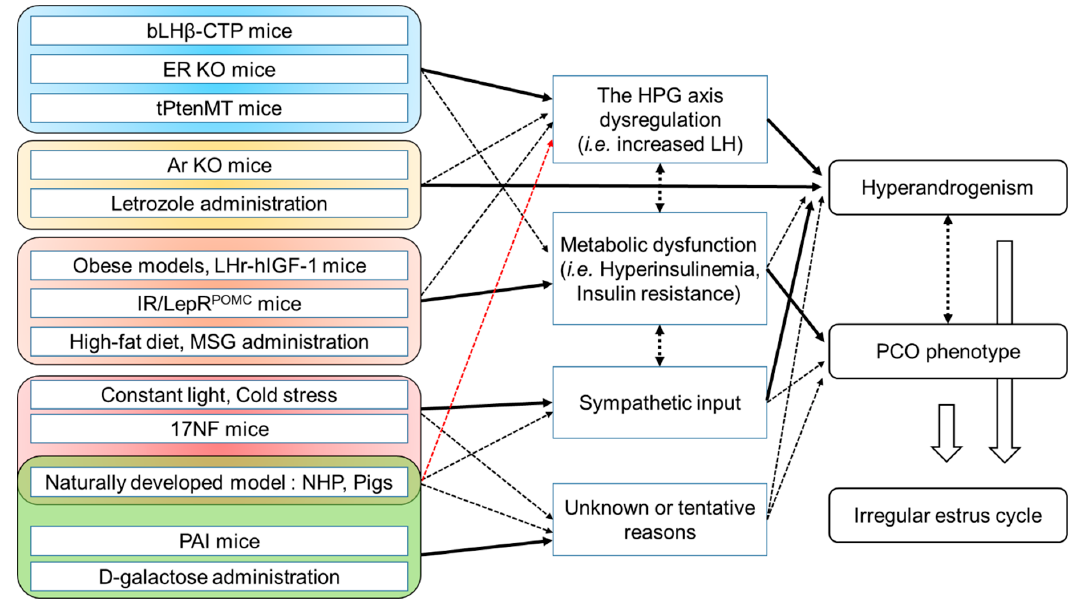
Figure 1. A schematic representation of the summarized pathophysiology to explain the manifestation of elevated testosterone levels and polycystic ovary (PCO) morphology. Solid lines indicate direct effects, and dotted lines, relatively weak or indirect effects. Two-headed arrows present cross-actions.